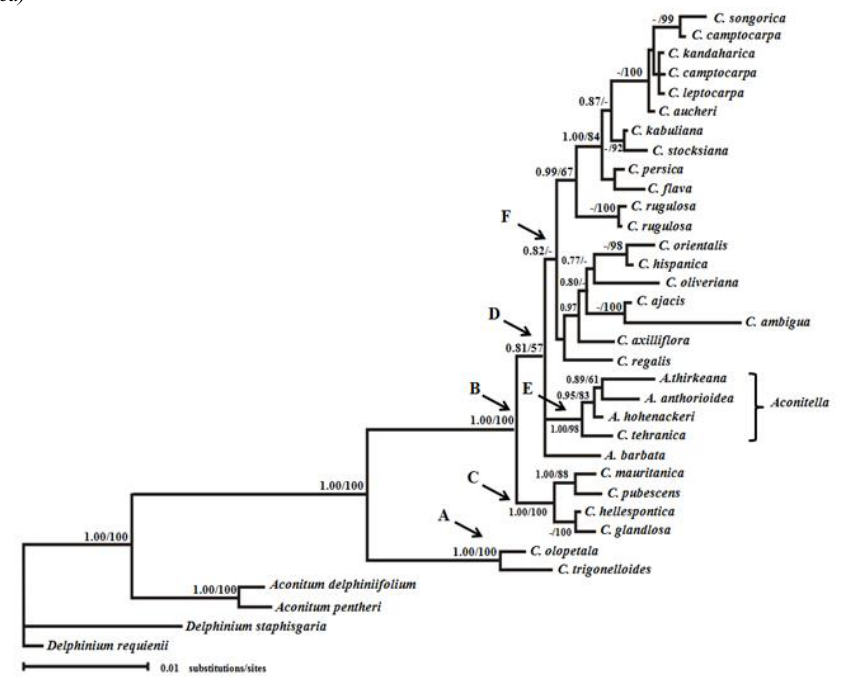
Fig. 2. Bayesian inference tree of data set nrDNA ITS in Consolida species: Numbers above the branches or arrows indicate Bayesian posterior probabilities (PP) and maximum parsimony bootstrap (MP). Values < 50% not shown. (C. tehranica =A.